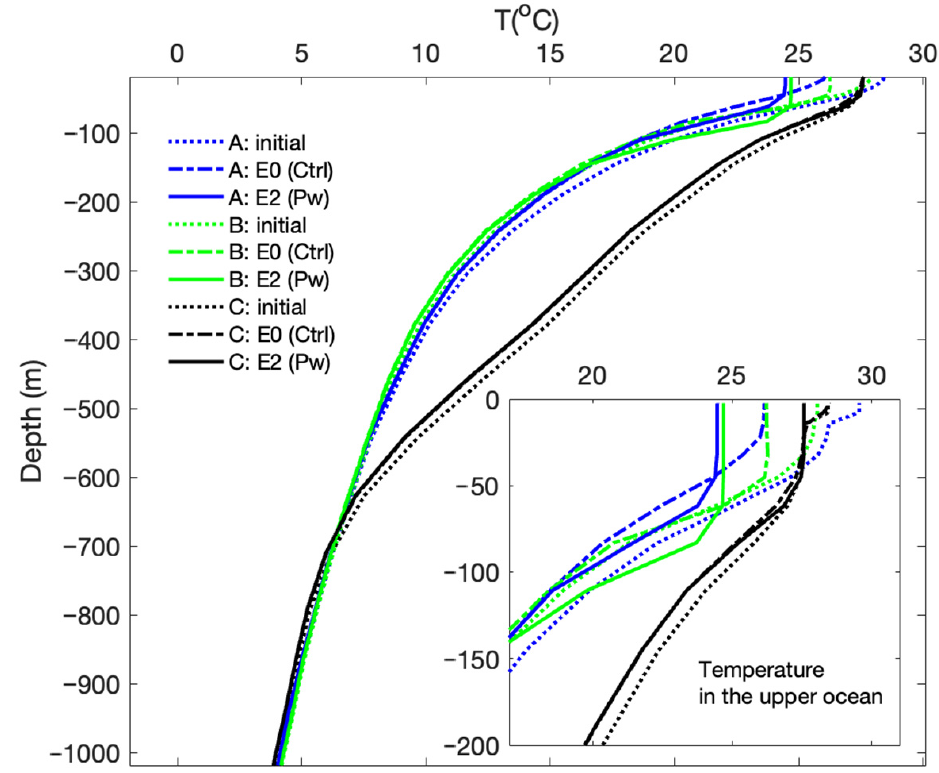
Figure 5. Water temperature profiles in zones A, B, and C at the initial time (dotted lines) and on 22 October (dash-dotted and solid lines).